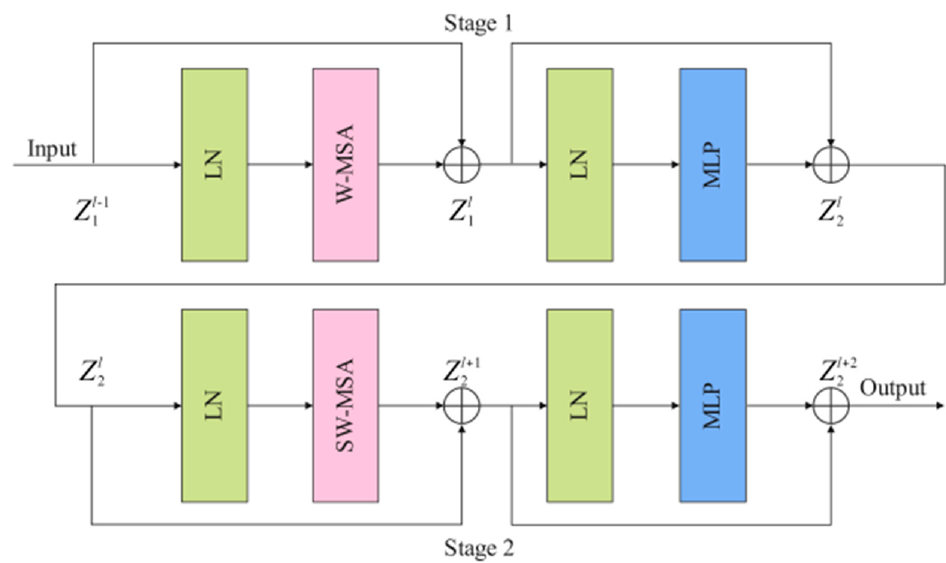
Figure 3. The implementation details of the Swin T block (LN: layer-norm, W-MSA: window-based multi-head self attention, SW-MSA: shifted window MSA, MLP: multi-head self-attention).